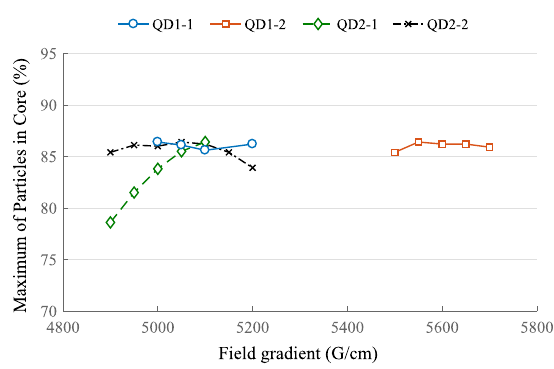
FIG. 4. Plot of overall maximum beam quality for different settings of each quadrupole in each doublet (e.g. QD1-2 is the first doublet ’ s second magnet).